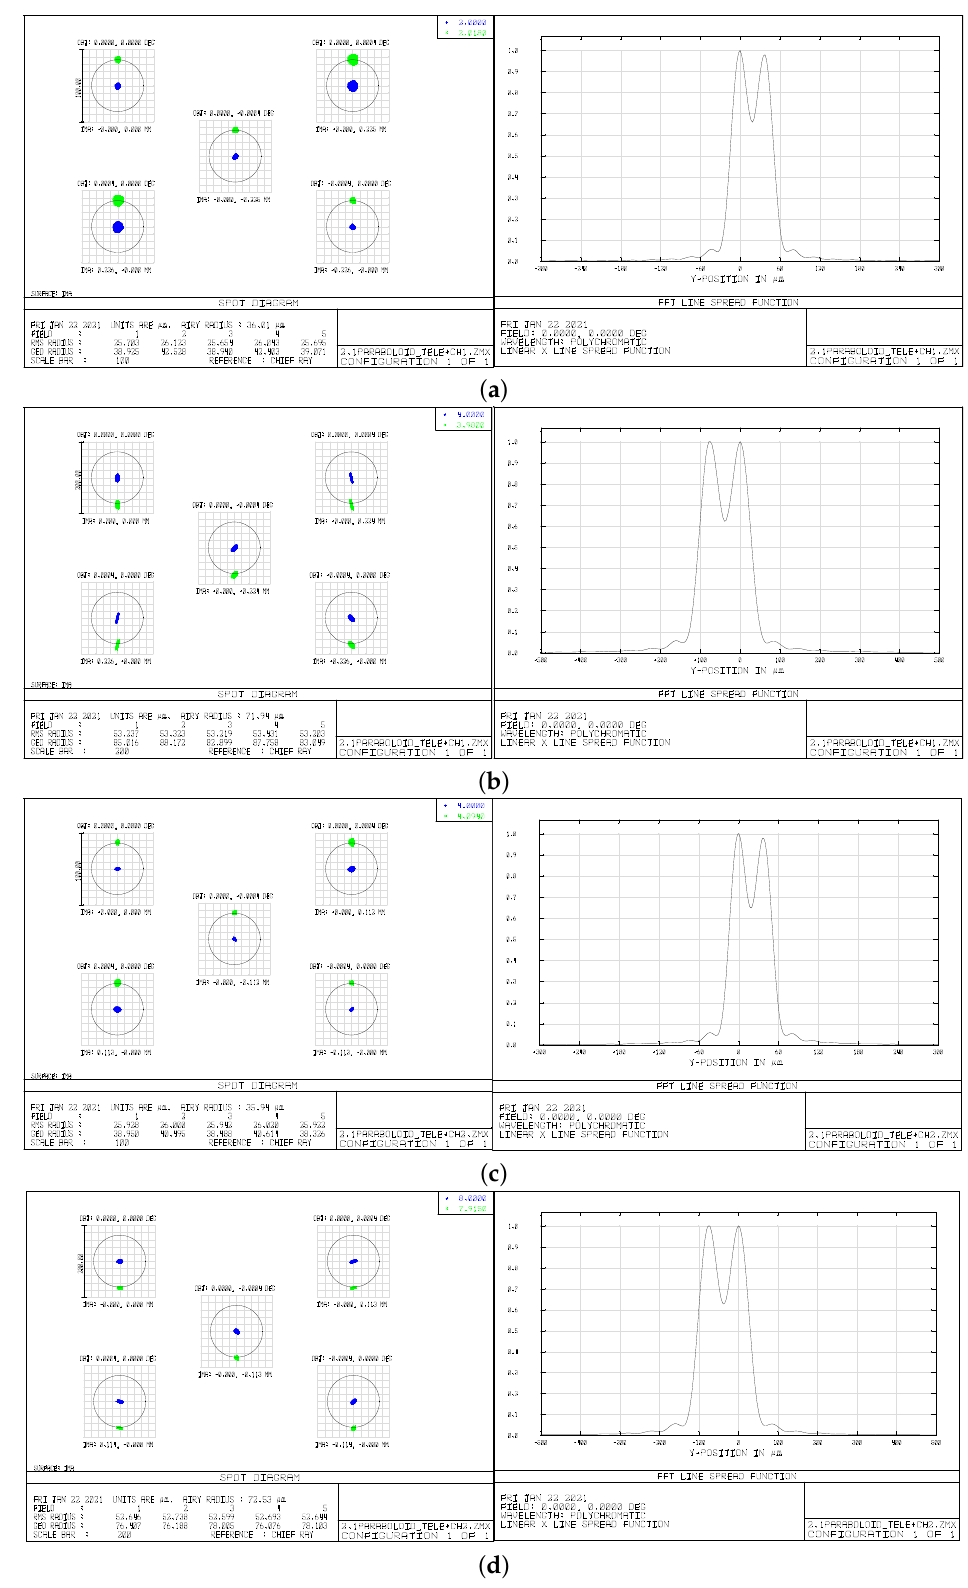
Figure 11. Spot diagrams and PSF curves of different channels and wavelengths ( a ) for CH1 at minimal wavelength, ( b ) for CH1 at maximal wavelength, ( c ) for CH2 at minimal wavelength, and ( d ) for CH2 at maximal